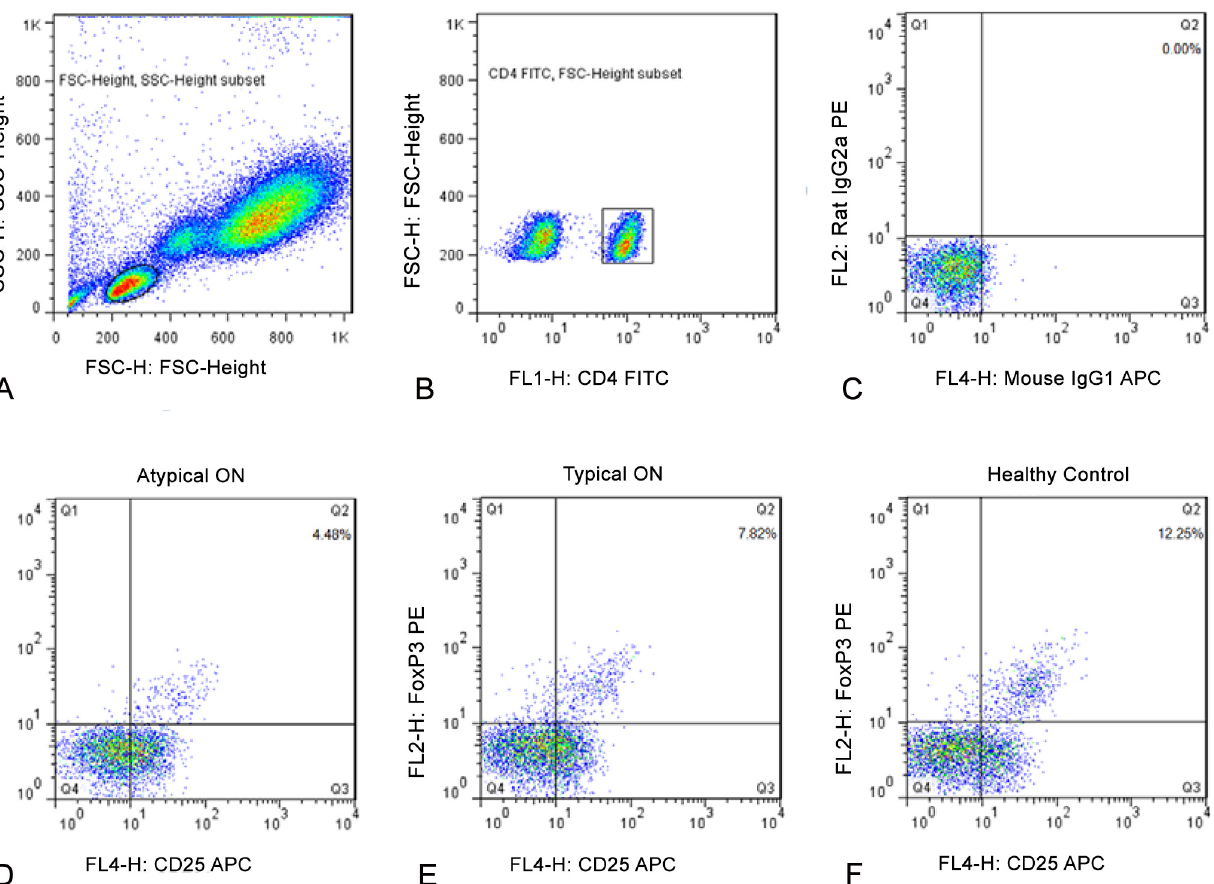
Fig 3. Proportion of CD4+CD25+FoxP3+ Treg cells in atypical ON, typical ON and controls. Lymphocyte ( A ), CD4+ T Cells ( B ), Isotype control staining of CD25 and FoxP3 ( C ), in a representative subject. Treg cells from representative patients with atypical ON ( D ) or typical ON ( E ), and from a healthy control subject ( F ). Note that the proportion of Treg cells is lowest in the atypical ON patient (D), intermediate in the typical ON patient (E) and highest in the control subject